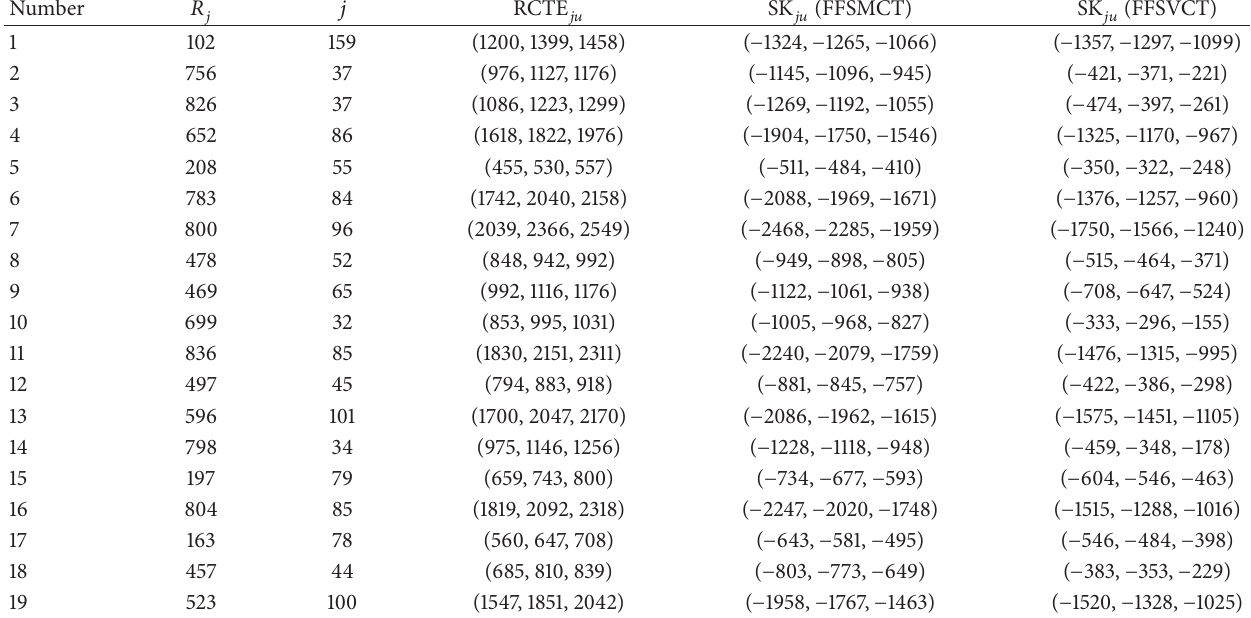
Table 2: An example ( 𝜆 =